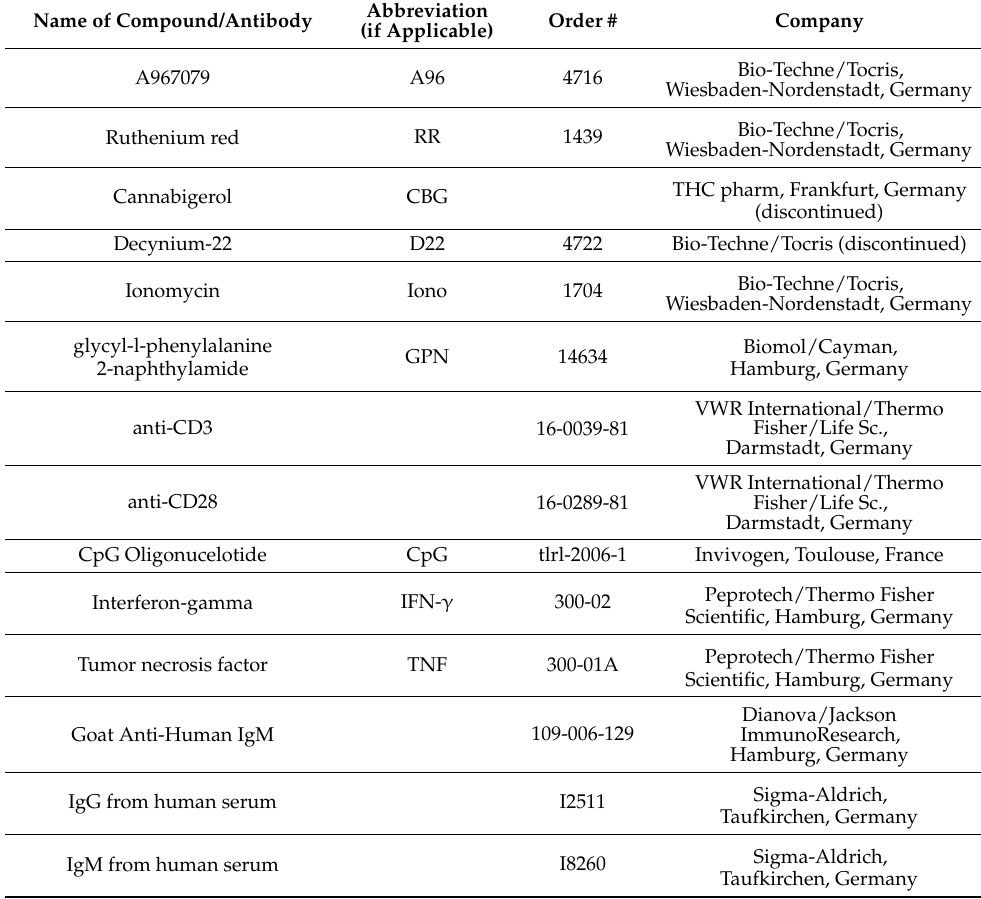
Table 1. Compounds and antibodies used in this